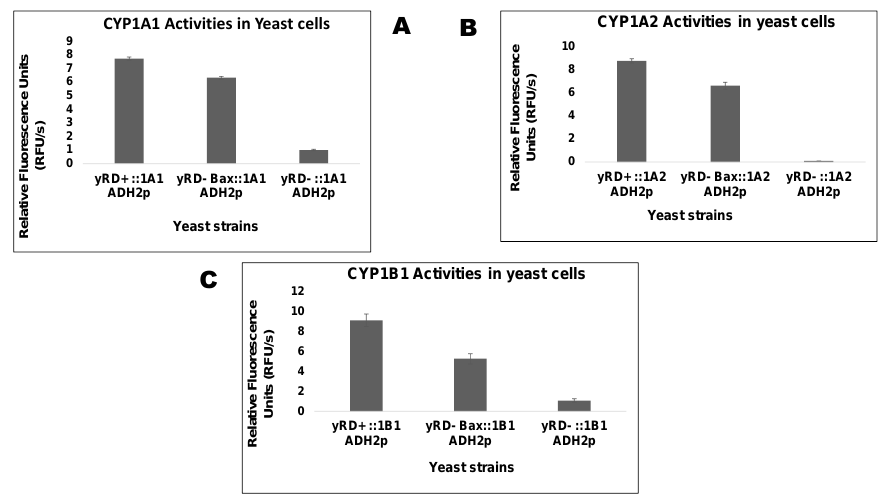
Figure 3. ( A ) Measurement of CYP1A1 activities in yeast strains, yRD + (+CPR), yRD − :: Bax (–CPR),